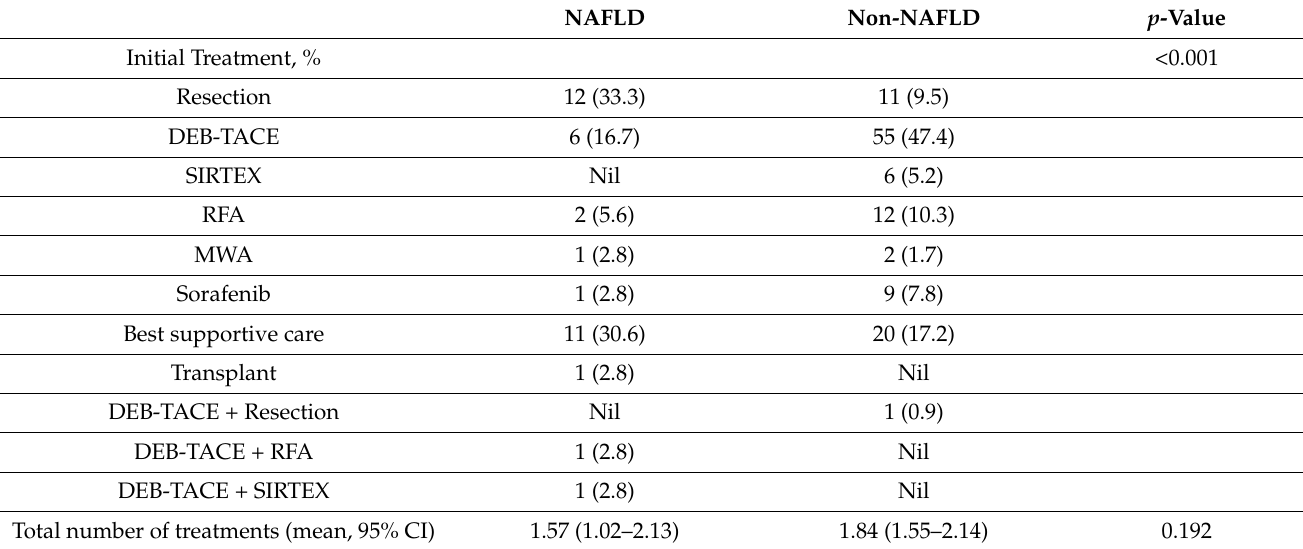
Table 3. Initial HCC treatment in NAFLD and non-NAFLD-HCC patients. NAFLD Non-NAFLD p